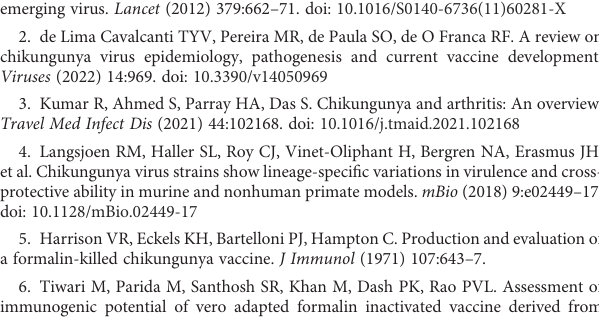
SUPPLEMENTARY TABLE 1 Characterization of mRNA formulation between wild-type (WT) and codon- optimized (OP) vaccines. Quality control parameters were examined after mRNA production. SUPPLEMENTARY FIGURE 1 Representative data examined for the wild-type (WT) and codon-optimized (OP) vaccines. Intensity size graphs for the (A) WT and (B) OP vaccines measured using the dynamic light-scattering method. mRNA content for (C) WT and (D) OP vaccines tested by Chromatographic